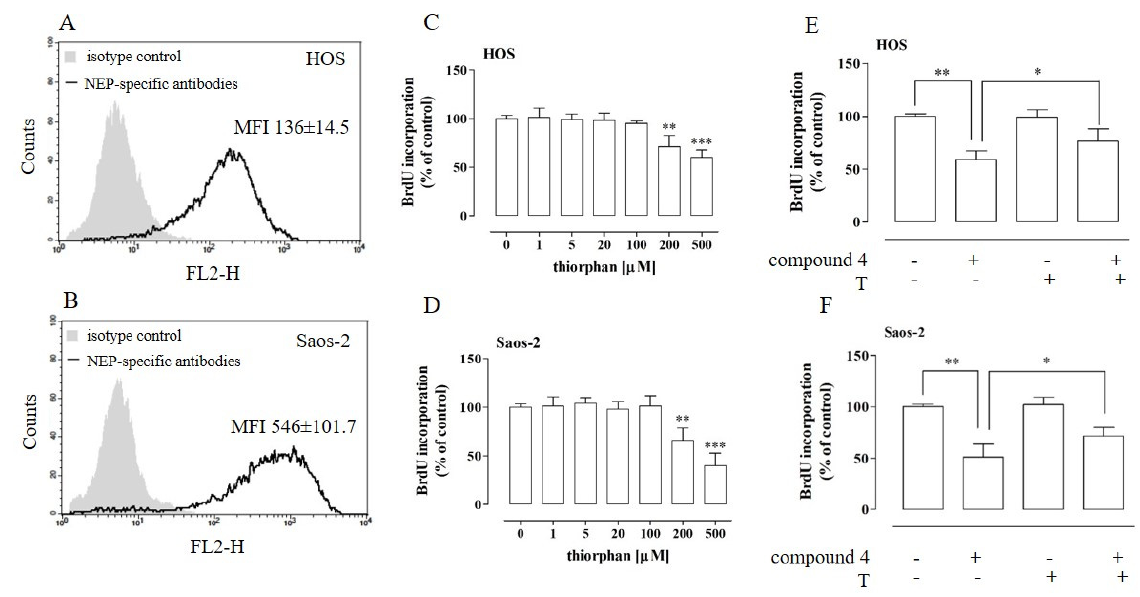
Figure 9. Effect of compound 4 on the proliferation of NEP-inhibited osteosarcoma HOS ( A , C , E ) and Saos-2 cells ( B , D , F ). The NEP expression in the osteosarcoma cells was examined by means of flow cytometry with PE-conjugated antibodies against human NEP ( A , B ). The cell proliferation after the treatment with non-cytotoxic concentrations of the NEP-specific inhibitor thiorphan was examined using the BrdU assay after a 96-h incubation ( C , D ). Proliferation of NEP-inhibited HOS ( E ) and Saos-2 ( F ) cells treated with compound 4 at concentrations of 25 µM and 60 µM (IC 50 ). The cells were pre-treated with 100 µM of thiorphan (T). The results are mean values ± SD of at least three independent experiments. Statistically significant differences: ** p < 0.01, *** p < 0.001, in comparison with the control untreated cells (0 µM) (unpaired T-test) ( C , D ), * p < 0.05 in comparison with the compound 4 -treated cells, and ** p < 0.01 in comparison with the control untreated cells (0 µM) ( E ,F) (one-way ANOVA followed by Tukey’s post-hoc test). MFI—mean fluorescence intensity.